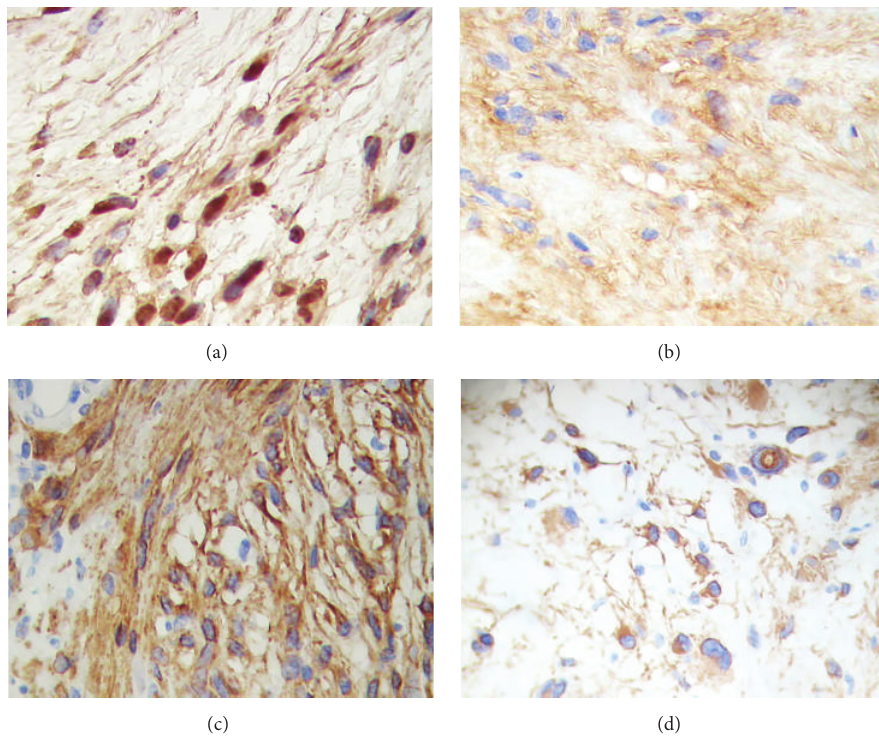
Figure 2: Immunohistochemistry panel. (a) PS100. (b) Collagen IV. ((c), (d)) Glial fibrillary acidic protein (GFAP) in an Antony A area (c) and in Antony B gemistocyte-like cells